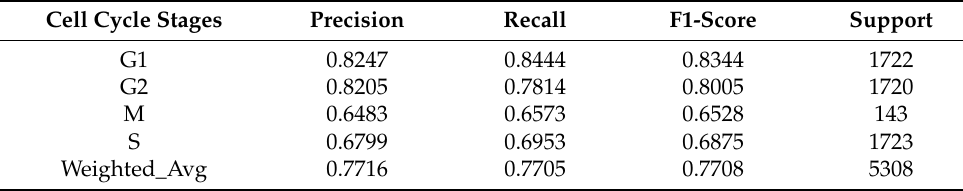
Table 7. The four-stage classification results for original